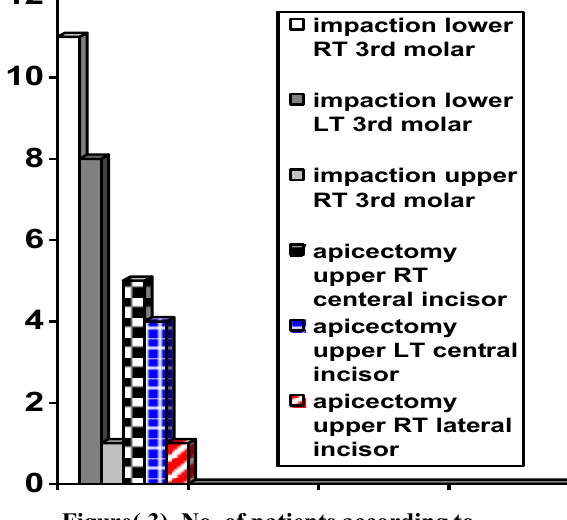
Figure( 3) No. of patients according